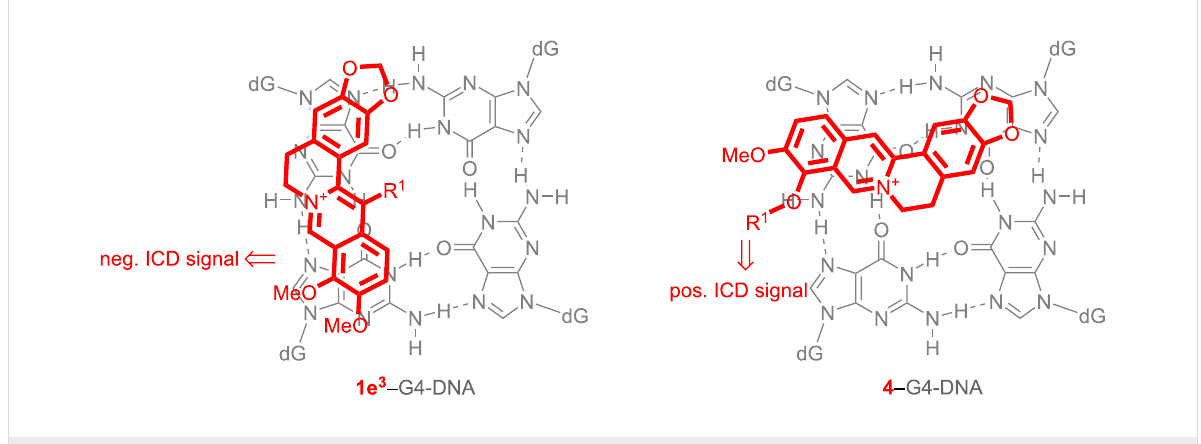
Figure 4: The simplified structure of the complex between 1e 3 and quadruplex DNA (left; [38]) and the proposed orientation of the ligands 4a – e with quadruplex DNA (right) according to ICD analysis (gray: G4 quartet; red: ligand).